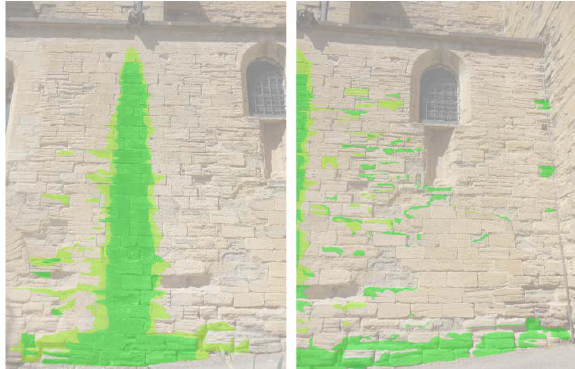
Figure 2. Maps of the areas affected by biological